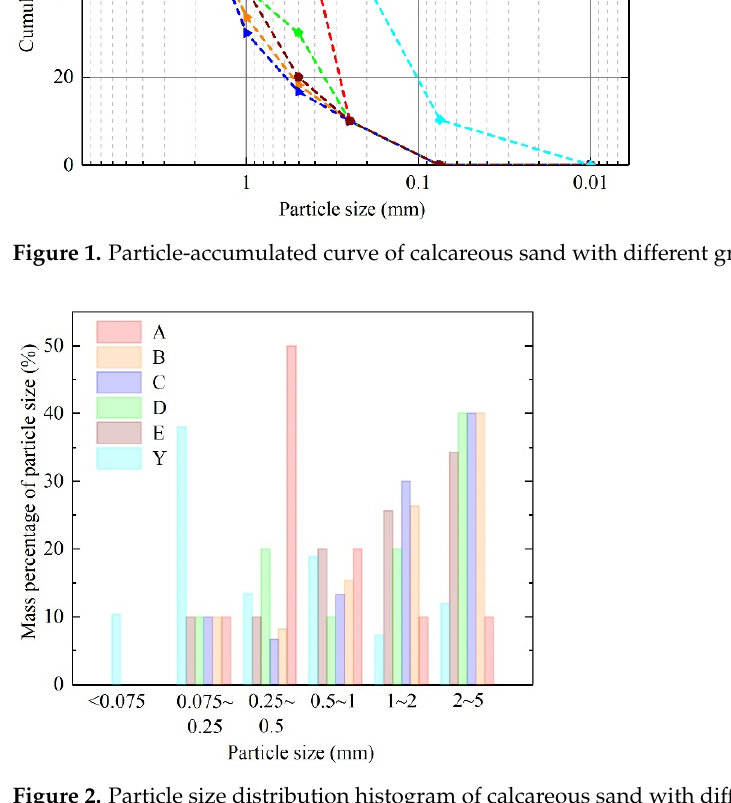
Figure 2. Particle size distribution histogram of calcareous sand with different gradations.